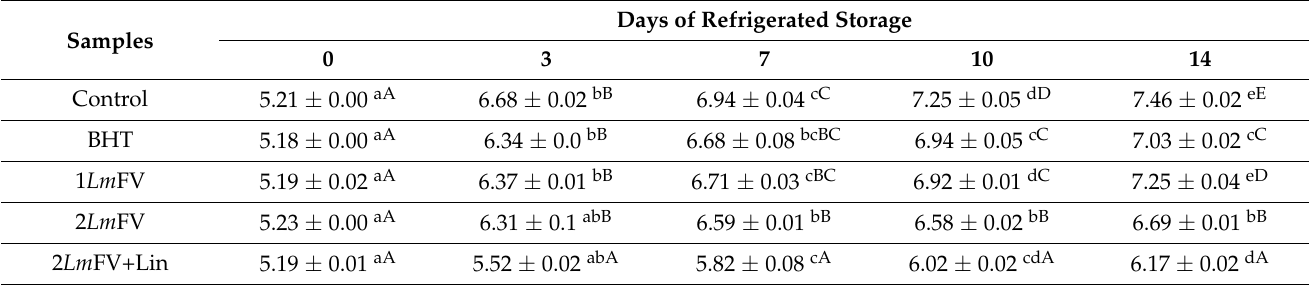
Table 6. pH values of raw minced beef samples stored at 4 ◦ C for 14